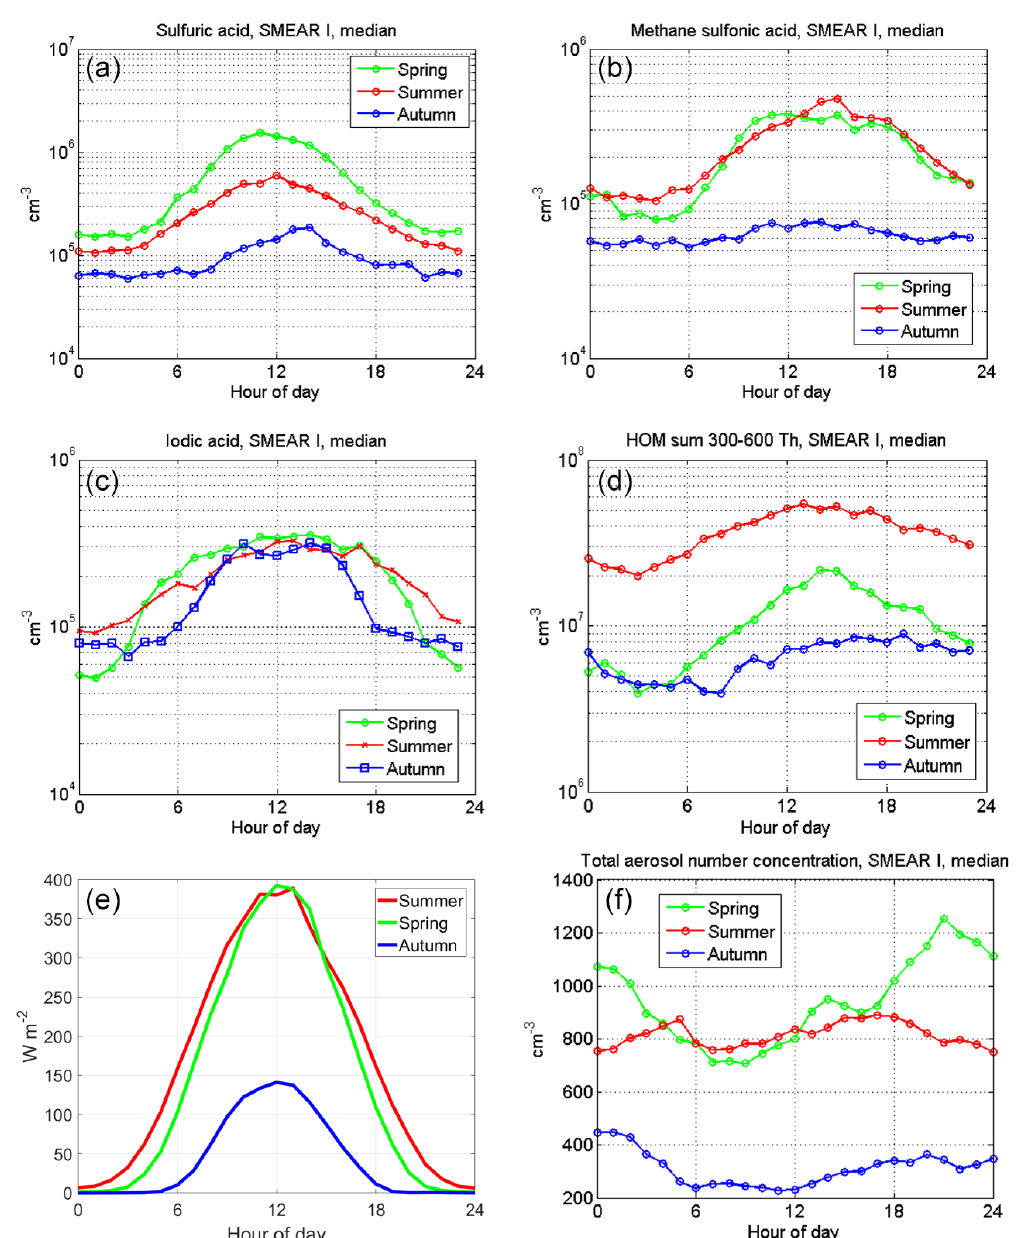
Figure 3. The diurnal variation in aerosol precursor gas median concentrations in different seasons for (a) sulfuric acid, (b) methane sulfonic acid, (c) iodic acid and (d) the sum of HOMs in the 300 to 600Th mass range. Panel (e) depicts the seasonal variation in global radiation, and panel (f) shows the seasonal variation in the total aerosol number concentration ( N tot ). The small (false) offset (6–7Wm − 2 ) in the summer data is due to 24h sunlight conditions in the Värriö